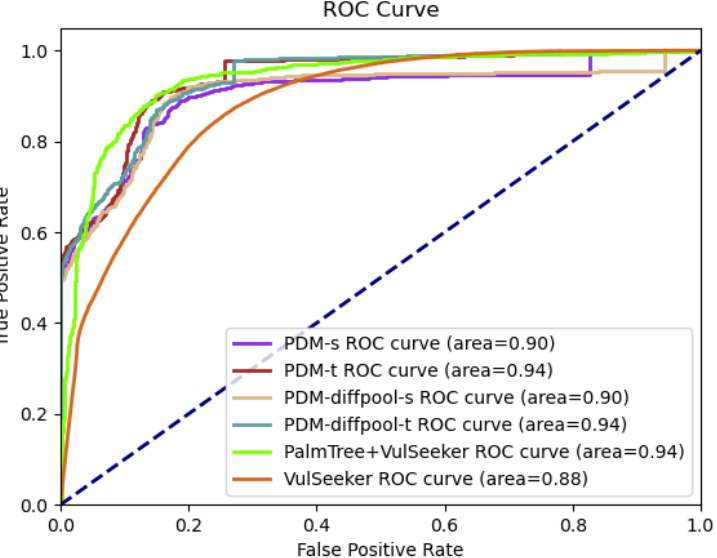
Figure 7. ROC curves and AUC values for VulSeeker, PalmTree + VulSeeker, and four versions of